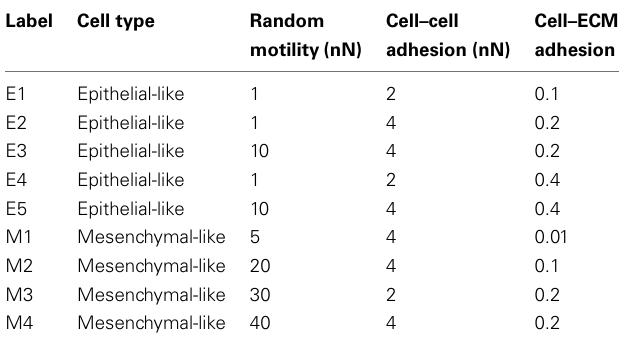
Table 2 | Parameter values for epithelial-like and mesenchymal-like cancer cells in simulations of tumor growth with heterogeneous cell